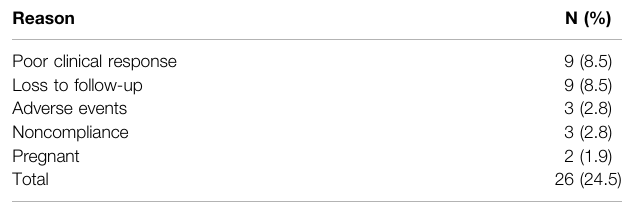
TABLE 2 | Different reasons for the dropout during the SLIT. Reason N (%)